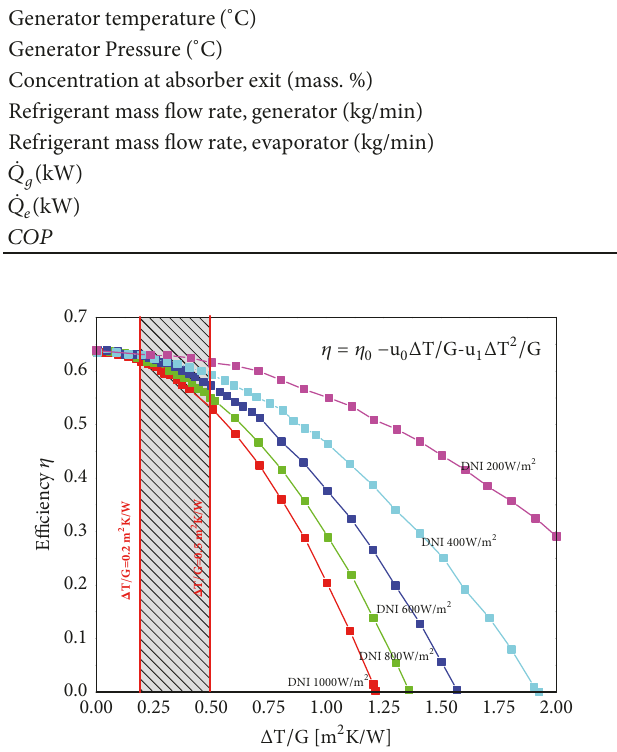
Figure 4: Collector thermal efficiency 𝜂 versus (Δ𝑇/𝐺) for various values of 𝐺